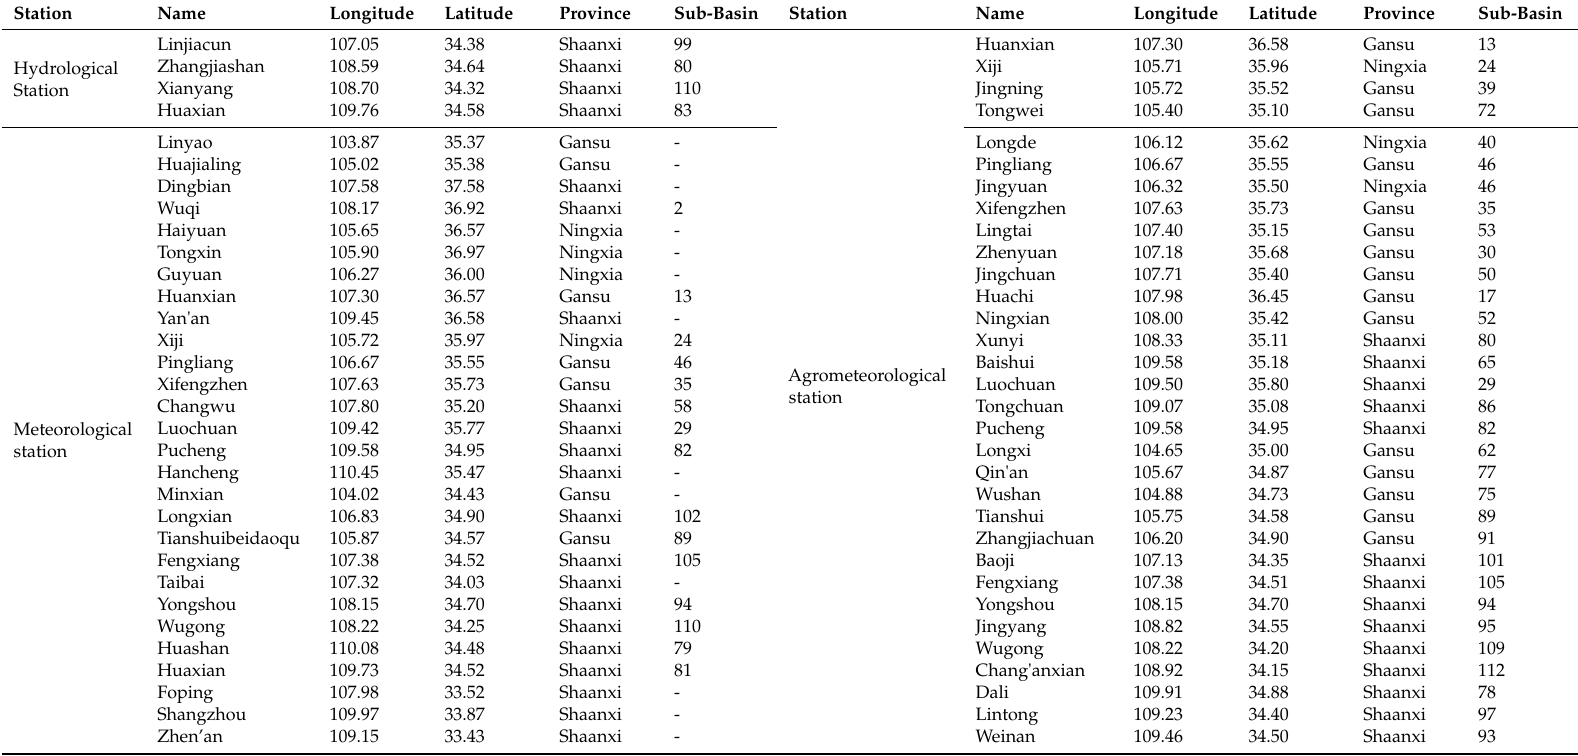
Table 1. Basic information of the